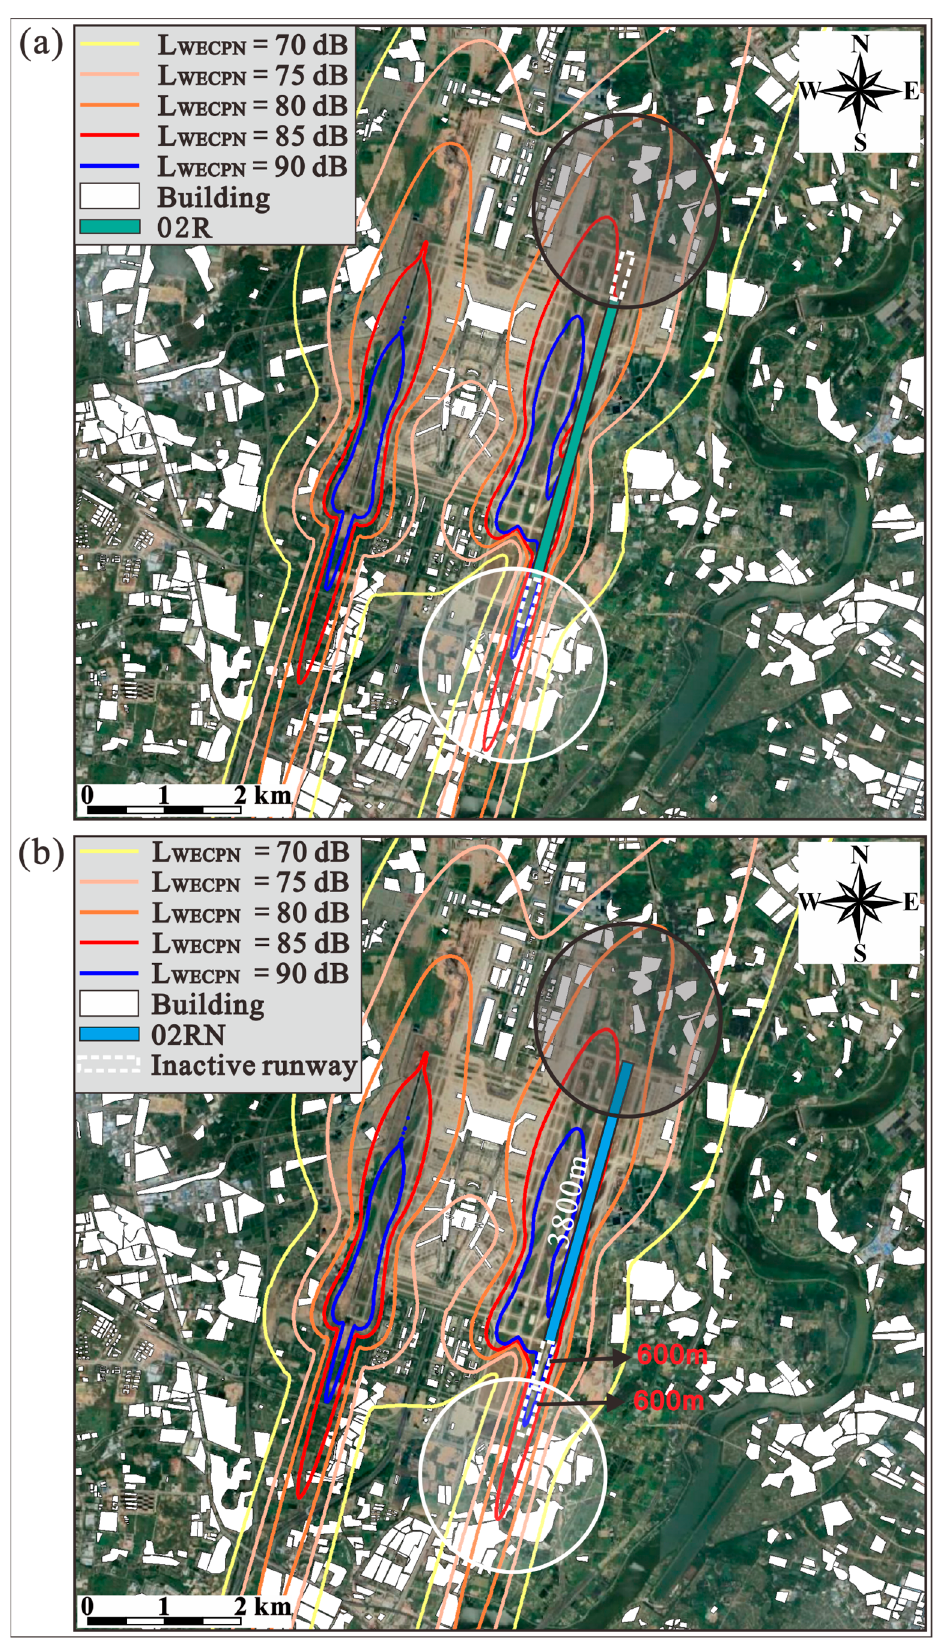
Figure 11. Noise contours ( a ) before and ( b ) after runway extension during winter.